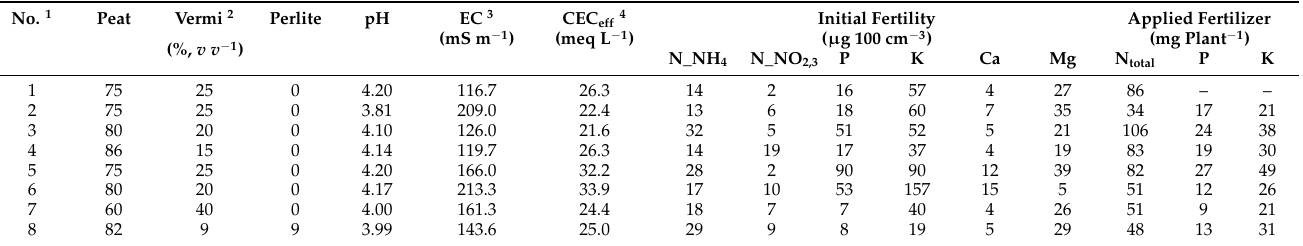
Table 1. Composition, chemical properties, and initial fertility of substrates after po tt ing ( n = 5), and quantities of nitrogen (N), phosphorous (P), and potassium (K) applied per seedling of white spruce (1+0) during the growing season in sampled forest nurseries.